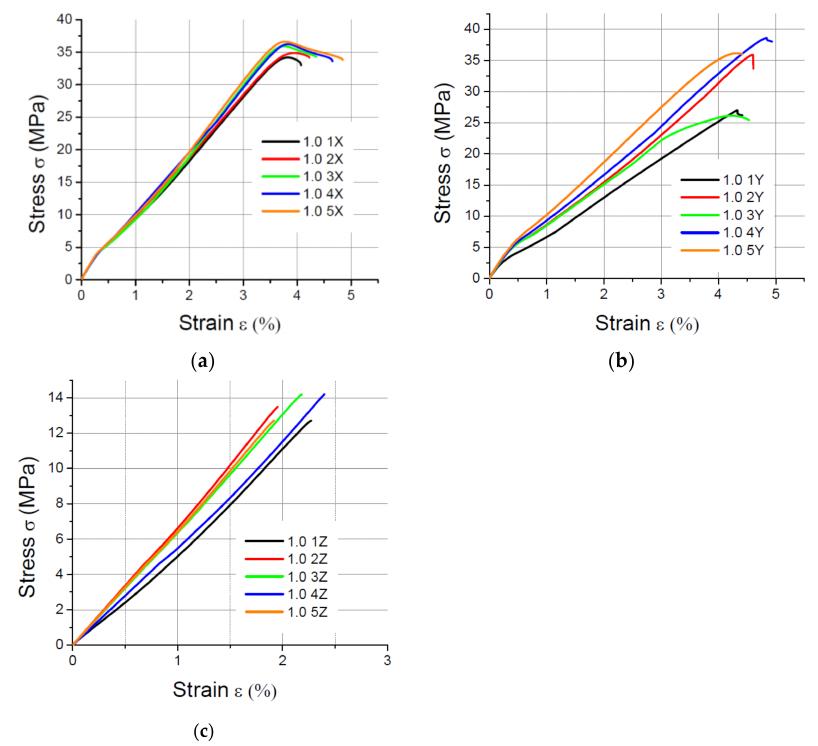
Figure 4. Tensile test results for 1 mm thick specimens made of PLA printed in ( a ) the X orientation; ( b ) the Y orientation; ( c ) the Z orientation.